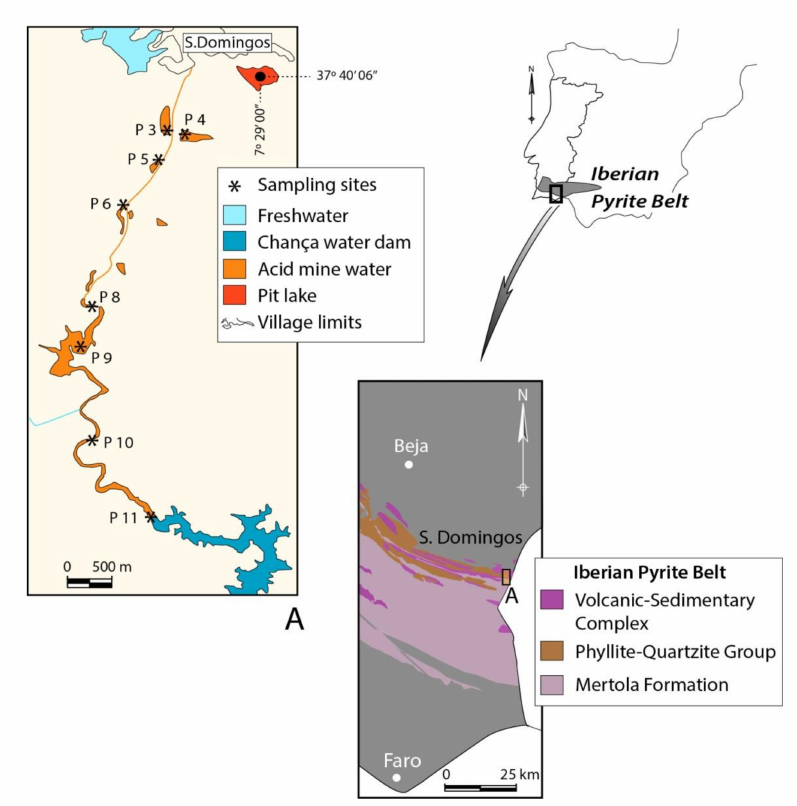
Figure 1. Map of the study area with representation of the geological context and the river system, with location of the sampling points. Adapted from [3].